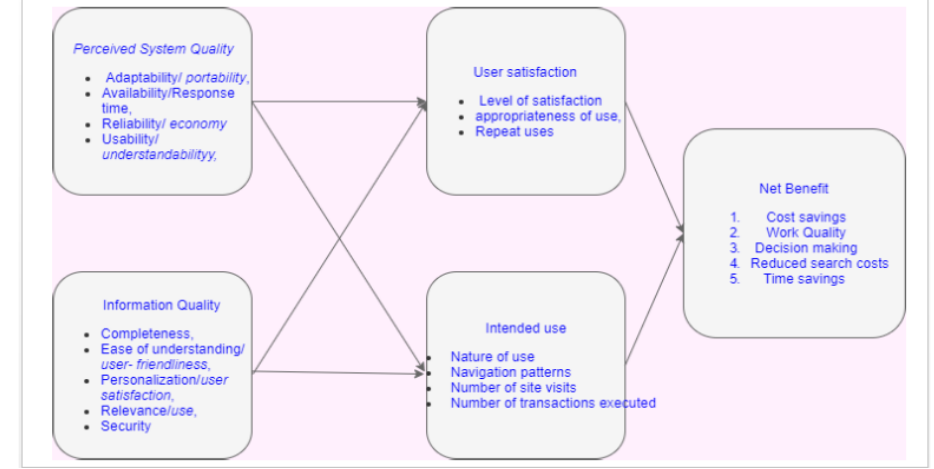
Figure 1: Research Concept; Source: DeLong and McLean modified Information Value models